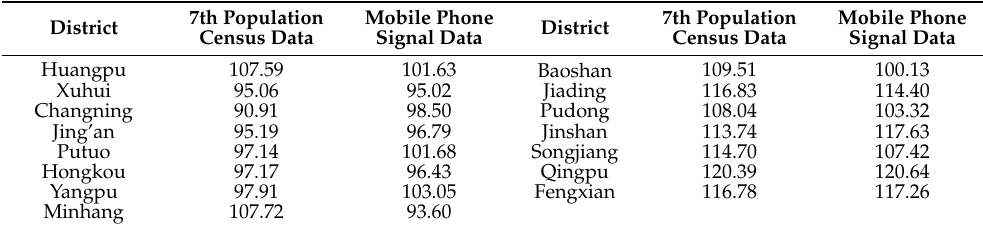
Table 3. Sex ratio in the districts of